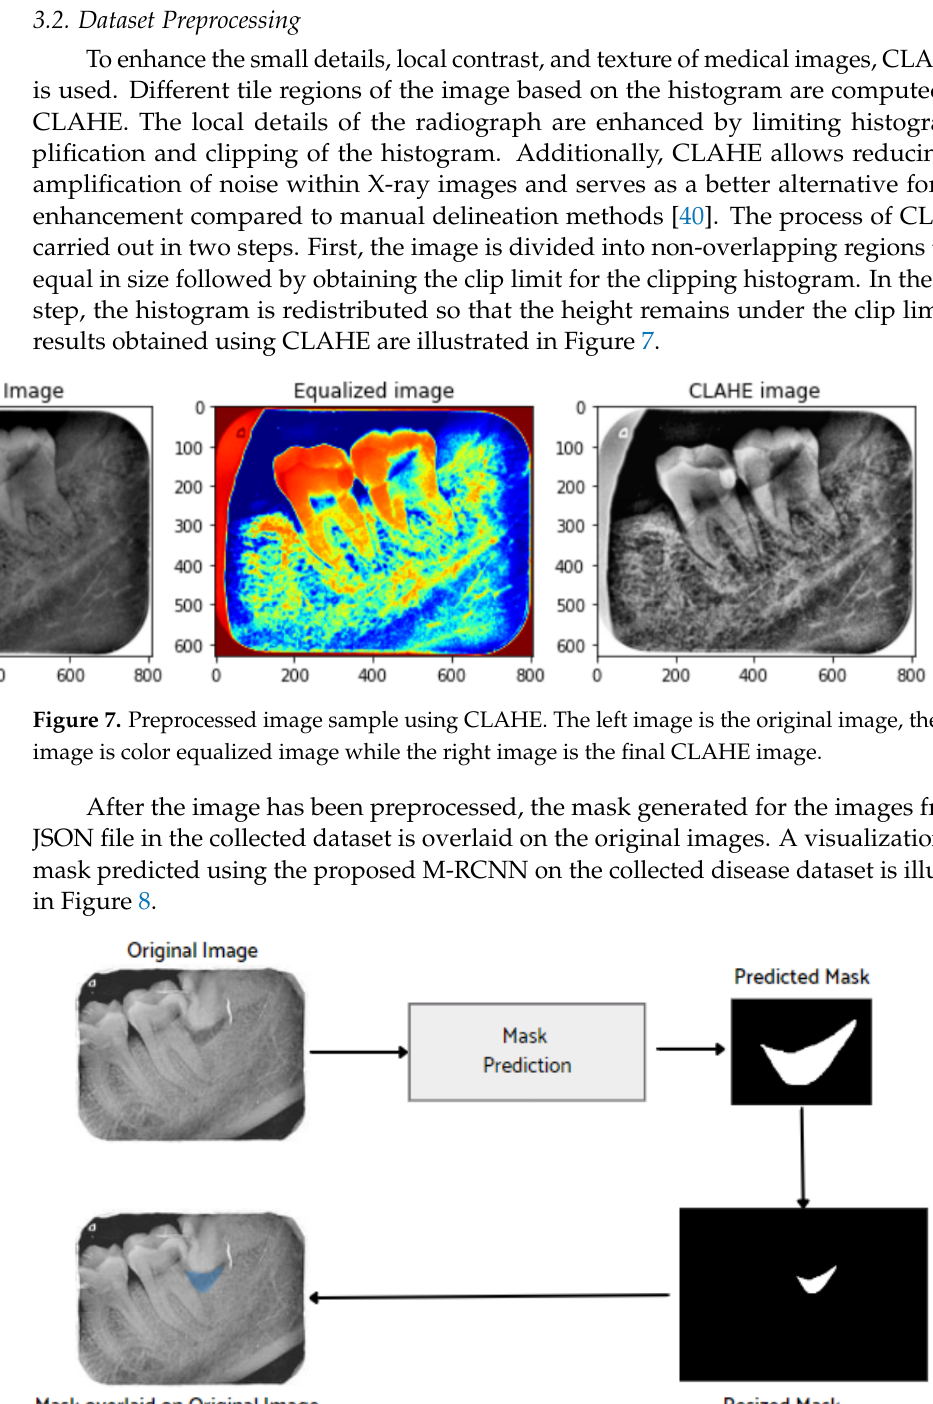
Figure 8. Mask overlaid on the original